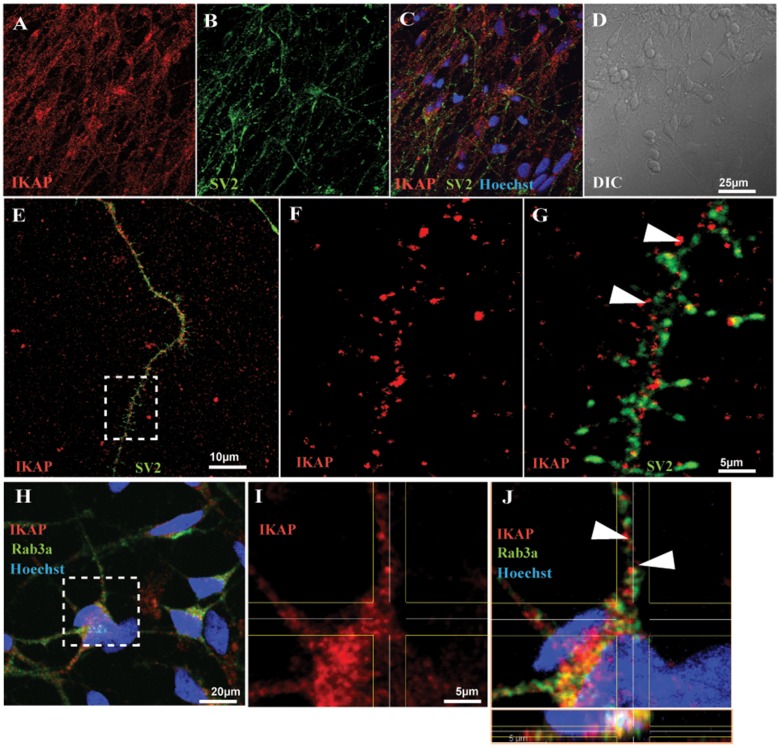
Localization of IKAP in hESC-derived PNS neurons in respect to vesicular neuronal markers SV2 and Rab3a.Confocal micrographs of hESC derived PNS neurons double-stained with Rabbit anti-hIKAP antibodies combined with either antibodies against synaptic vesicular markers, synaptic vesicle 2 (SV2) (A-G) or with Rab3a (H-J). (A-D) Low magnification images showing the IKAP and SV2 coexpression within neurites. (E-G) Magnification of a neurite exhibiting granular expression of IKAP and SV2. (F and G) High magnification of boxed area in E, showing partial colocalization of the two proteins (indicated by arrowheads in G) within distinct vesicle structures. (H) Low magnification image showing IKAP and Rab3a localization within the soma and along neurites. (I and J) High magnification of boxed area in H exhibiting partial protein colocalization pattern within distinct vesicles (indicated by arrowheads in J). Scale bars are indicated according to the magnification in each image.